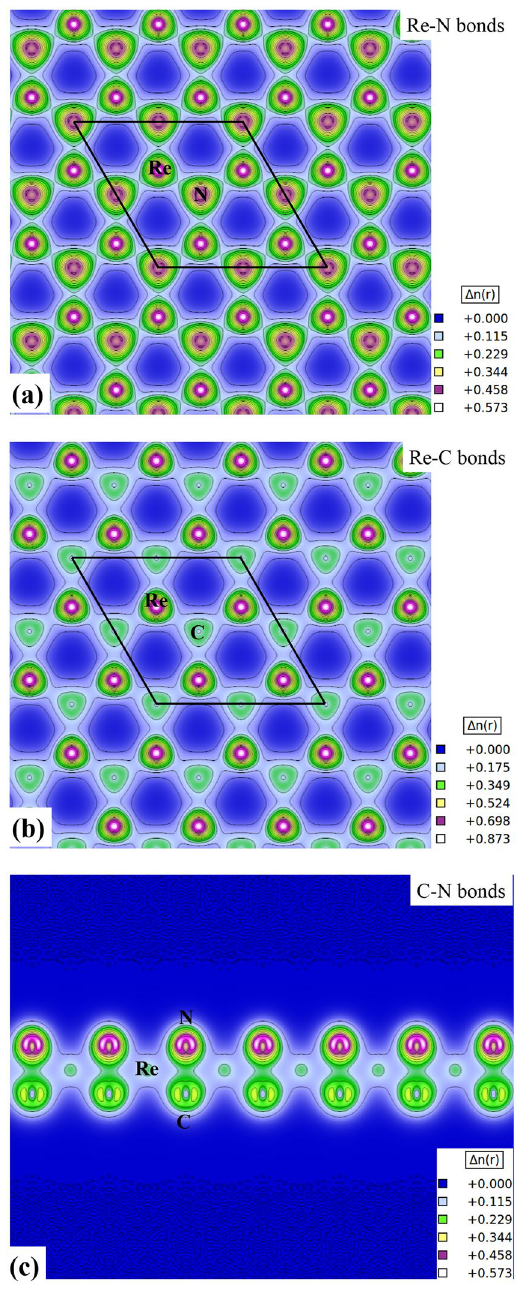
Figure 10. Charge density distributions for preferential planes in the ReCN monolayer: ( a ) Re-N bonds, ( b ) Re-C bonds, and ( c ) C-N bonds. Blue color corresponds to low charge density, and white color to high charge density concentration (value found only at the atomic